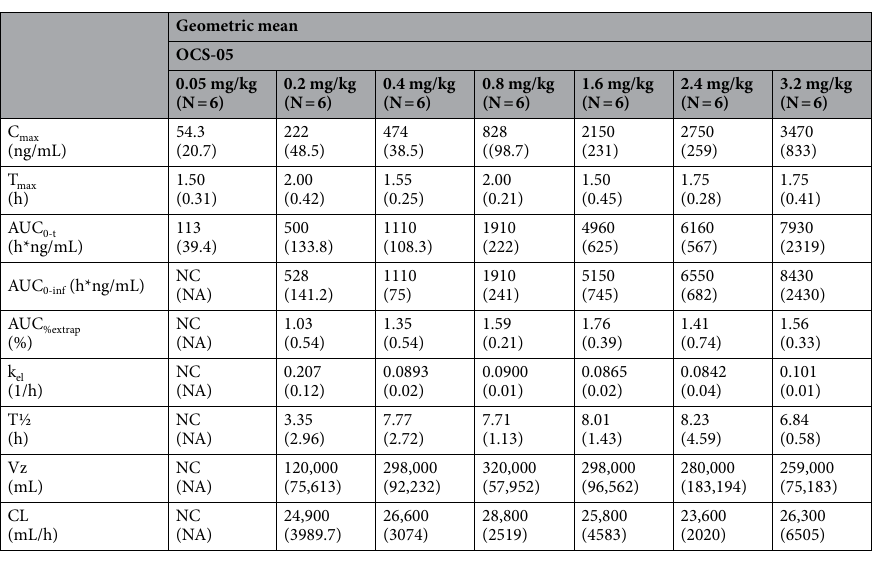
Table 4. Summary of derived pharmacokinetic parameters following single dose administration of OCS-05 (i.v. infusion) to healthy subjects as means